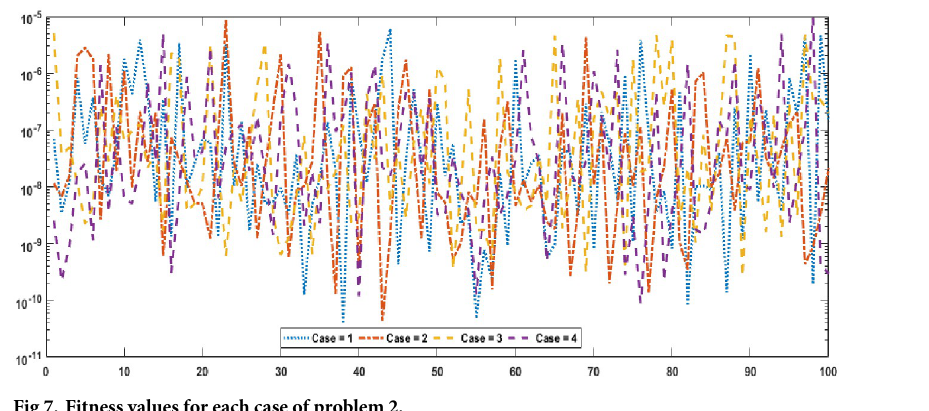
Fig 7. Fitness values for each case of problem 2.